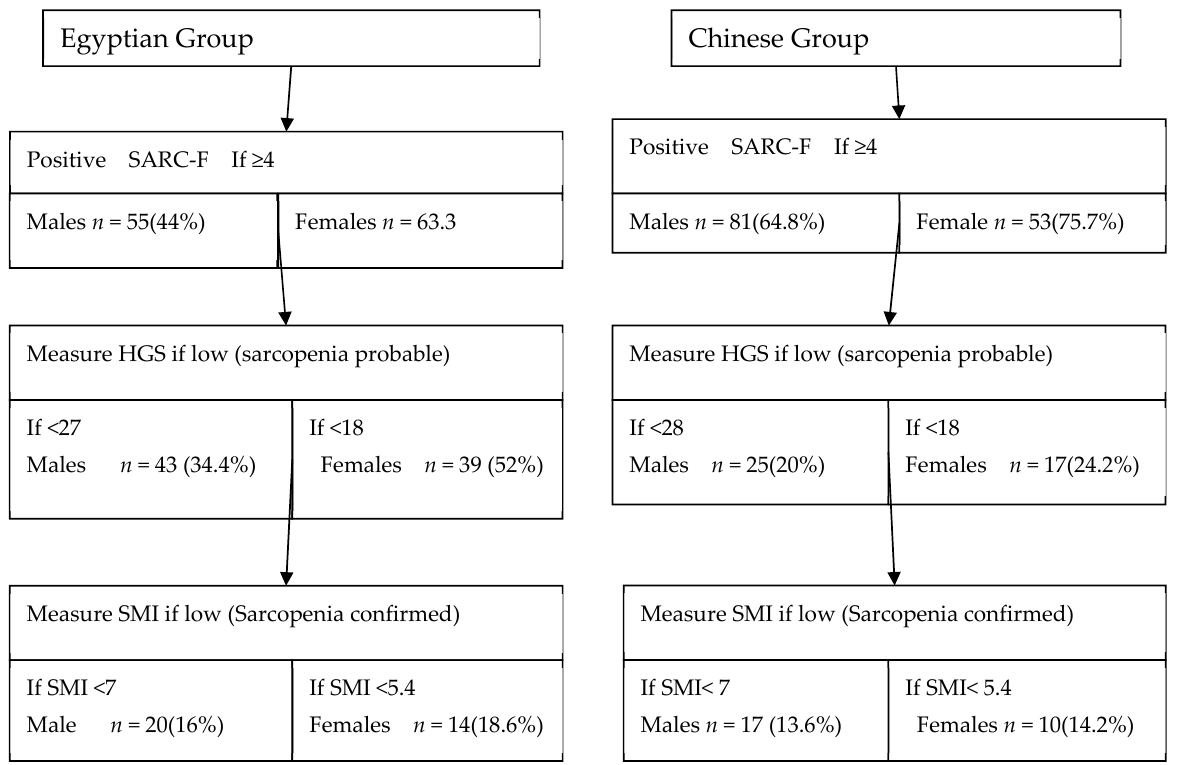
Figure 2. Prevalence of stroke-related sarcopenia in both Egyptian and Chinese populations using AWGS-2019.